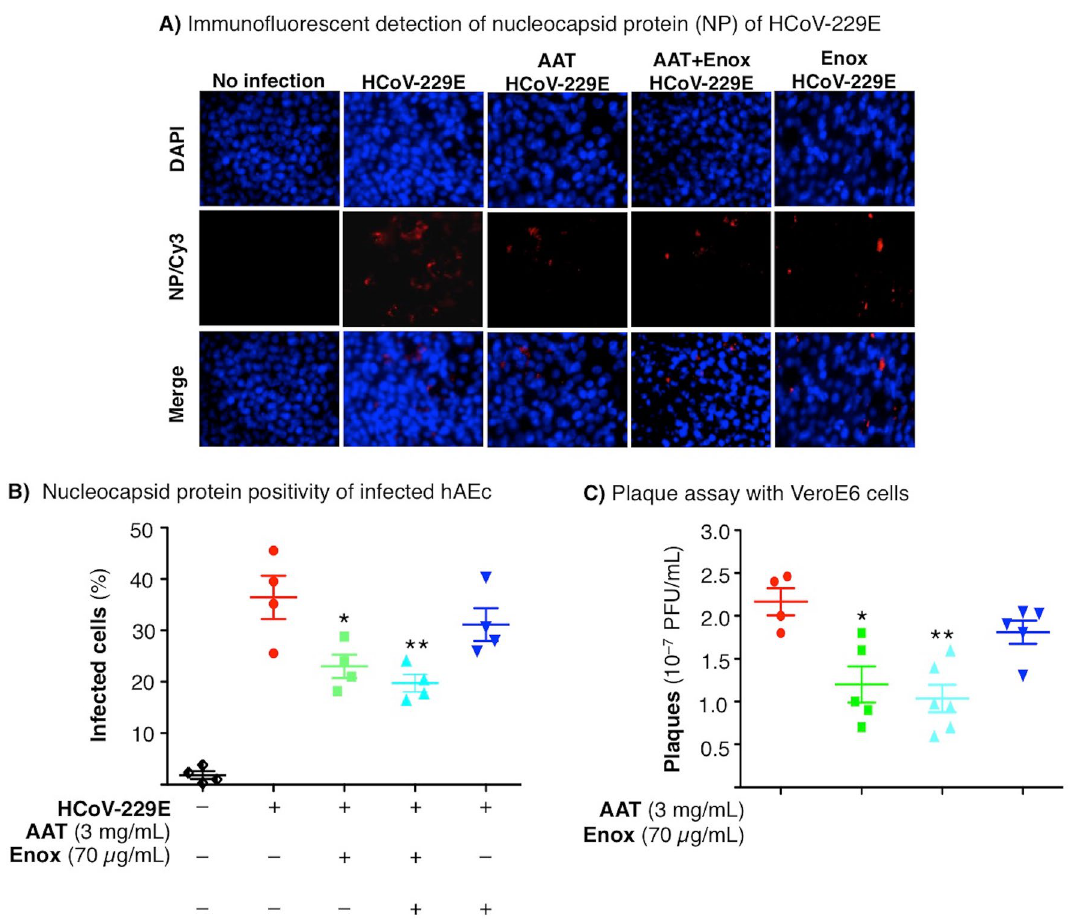
Figure 5. Effects of AAT, enoxaparin, or both on infection of hAEc with HCoV-229E. ( A ) Immunofluorescence analysis of HCoV-229E-infected hAEc grown in air–liquid interface. The hAEc were pre-treated with AAT (3 mg/mL), enoxaparin (70 µg/mL), or both for 1 h, and then infected with HCoV-229E at a multiplicity-of- infection of 1 hAEc:0.01 HCoV-229E. Three days after infection, the cells were fluorescently immunostained for the nucleocapsid protein of HCoV-229E. The nuclei were stained with DAPI. Fluorescent images were taken at a magnification of 400X by confocal microscopy (Carl Zeiss Anxiovert 200 M). ( B ) Percentage of HCoV- 229E-infected hAEc with > 700 total cells counted for each condition. Data shown are the mean ± SEM of three independent experiments. *p < 0.05, **p < 0.01 compared to HCoV-229E infection alone. ( C ) Plaque assay. The apical chamber medium of HCoV-229E-infected hAEc were used to infect VeroE6 cells and incubated for 4–5 days. Infection of the hAEc were done in triplicates and subsequent infection of VeroE6 cells with the supernatant of HCoV-229E-infected hAEc were each done in triplicates. Thus, the data shown are the triplicate means ± SEM of the original triplicate experiments. *p < 0.05 and **p < 0.01 compared to cells infected with HCoV-229E only without treatment. hAEc = primary human airway epithelial cells, HCoV-229E = human coronavirus